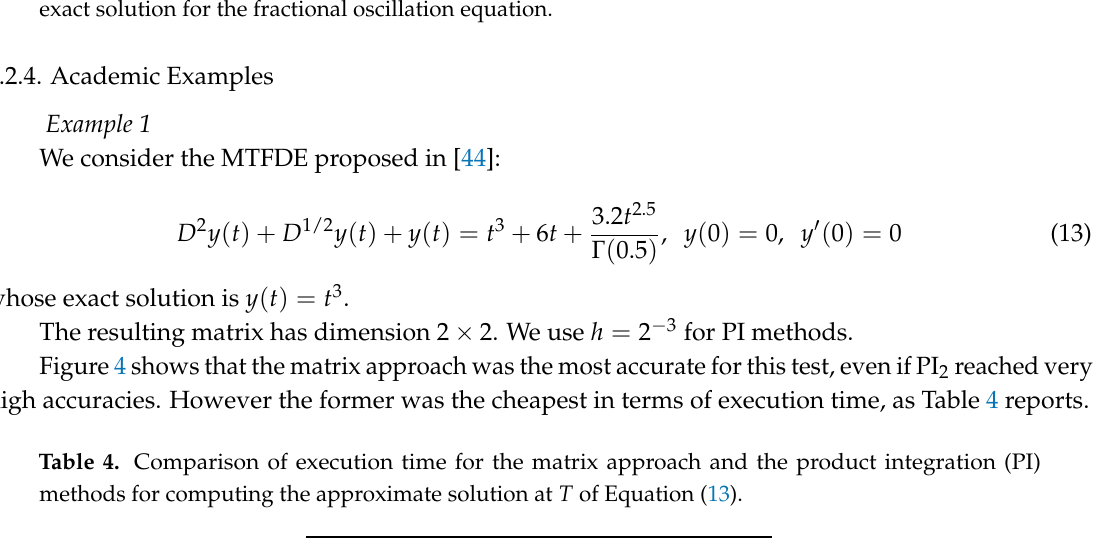
Figure 3. Error for the matrix approach and the product integration (PI) methods compared with the exact solution for the fractional oscillation equation.